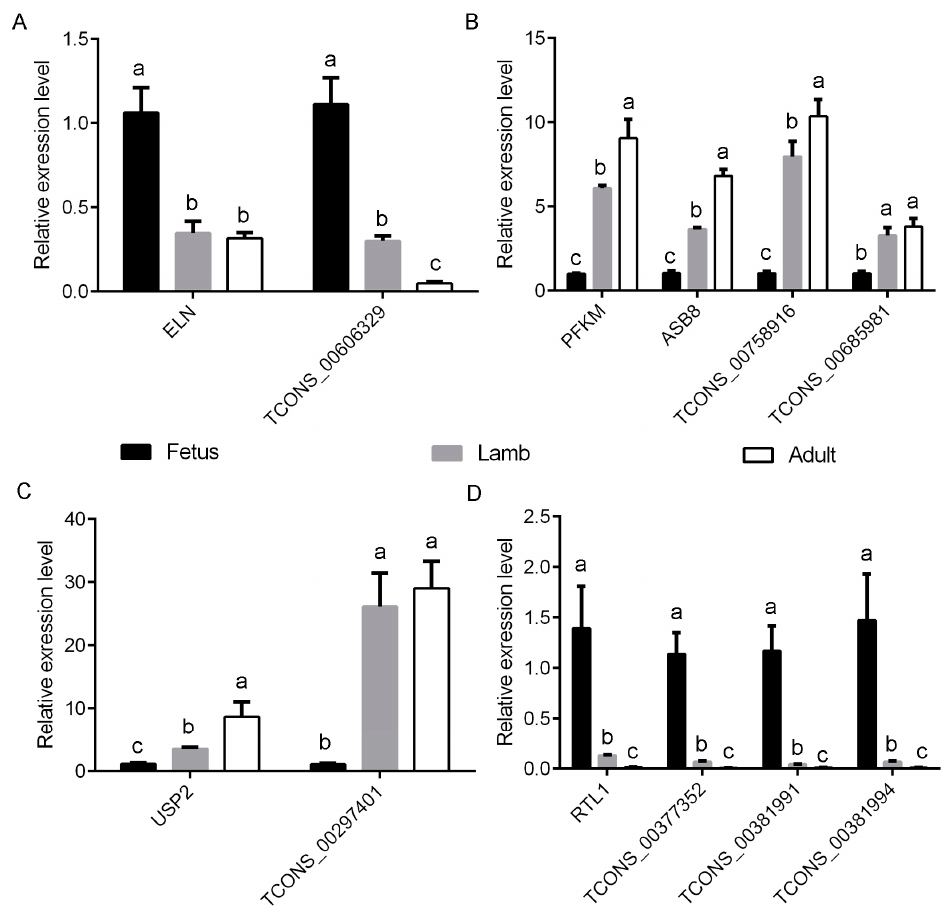
Figure 9. The verification of the expression level of the differentially expressed lncRNAs and the co-expressed target genes at fetus, lamb and adult stages measured by qRT-PCR. ( A ) The relative expression of TCONS_00606329 and target gene ELN. ( B ) The relative expression of TCONS_00758916 and TCONS_00685981 and the target genes PFKM and ASB8. ( C ) The relative expression of TCONS_00297401 and the target gene USP2. ( D ) The relative expression of TCONS_00377352, TCONS_00381991 and TCONS_00381994 and their target gene RTL1. The qRT-PCR data were represented as the mean ± SEM of three biological and technical replicates. Columns with different letters are significantly different at p <